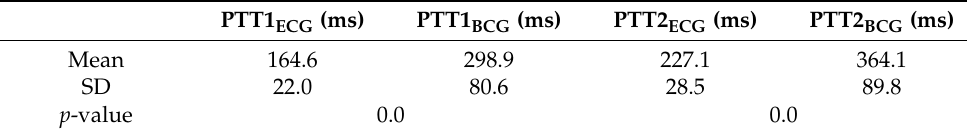
ps: SD is the abbreviation of standard